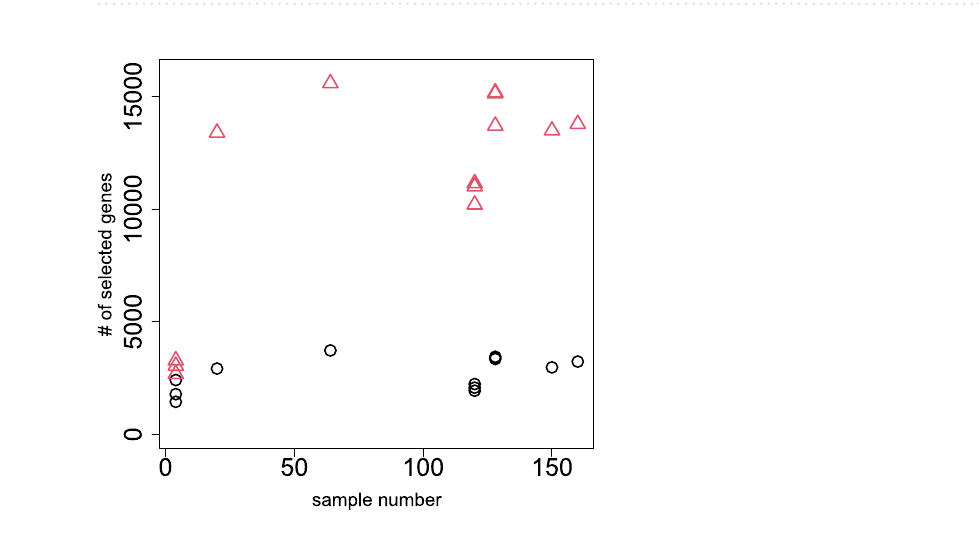
Figure 10. Dependence of the number of DEGs on sample numbers using the SEQC data set. Open circles: the number of genes selected by PCA-based unsupervised FE with optimized SD. Open red triangles:the number of genes selected by